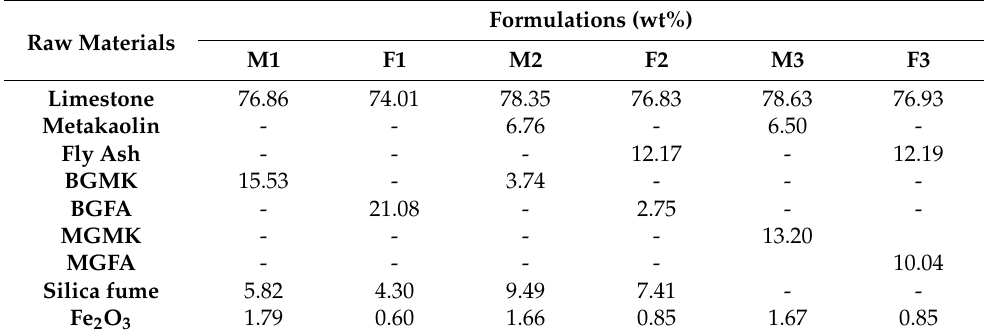
Table 2. Investigated formulations (wt%).